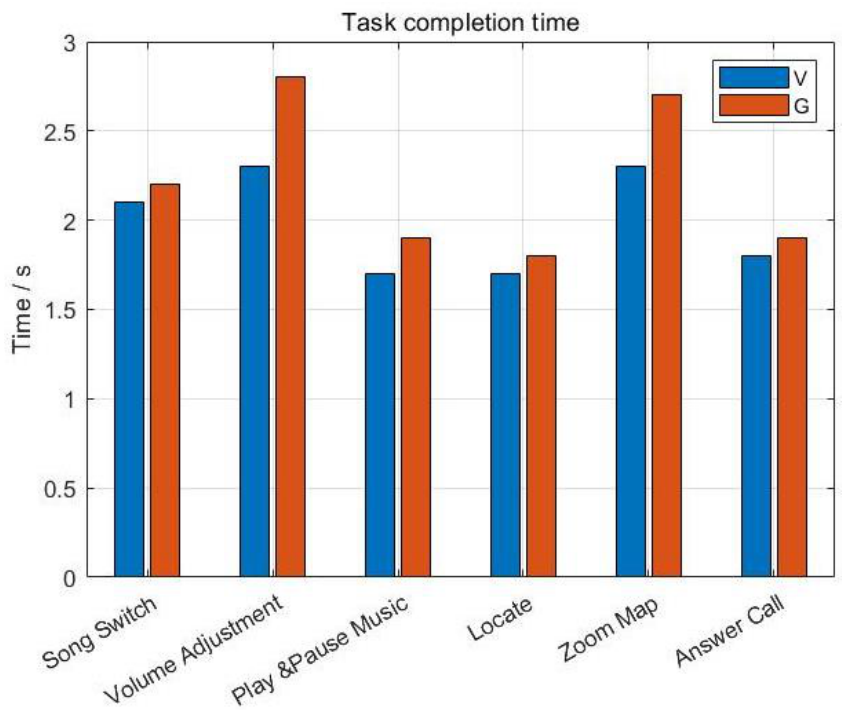
Figure 11. Task completion time. V stands for Visual Interface. G stands for Gesture